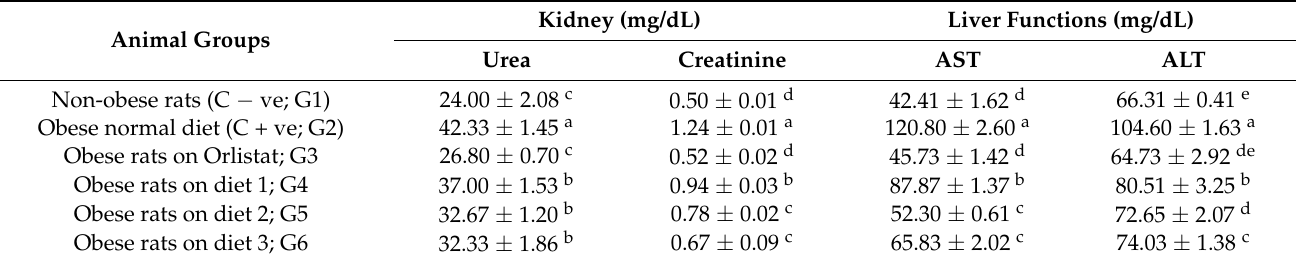
Table 5. Effects of biscuits supplemented with different DF levels on kidney and liver functions in obese